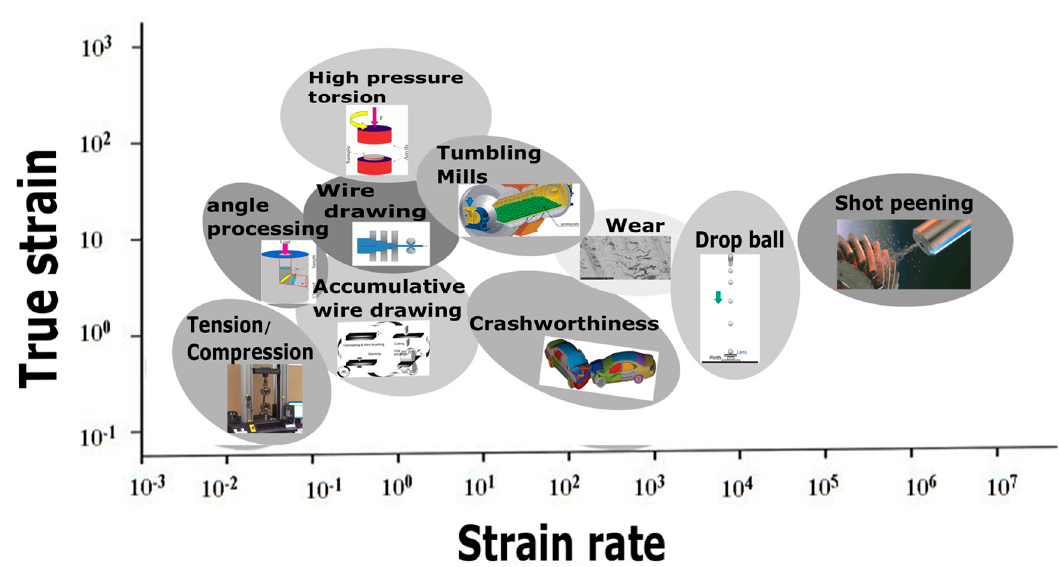
Figure 2. Range of strain rates and strain accumulation in various deformation processes.